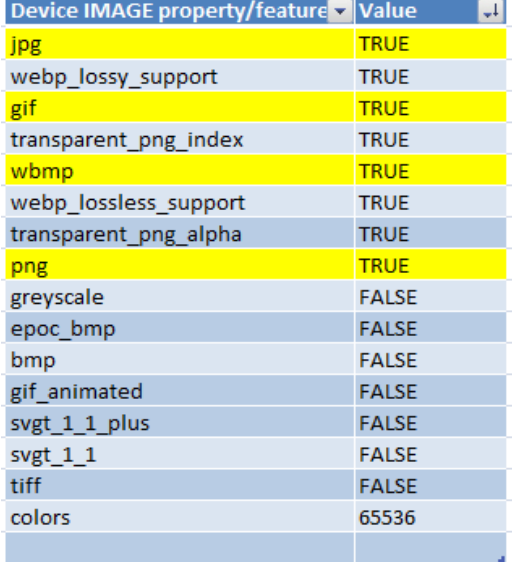
Fig. 4. Device Image